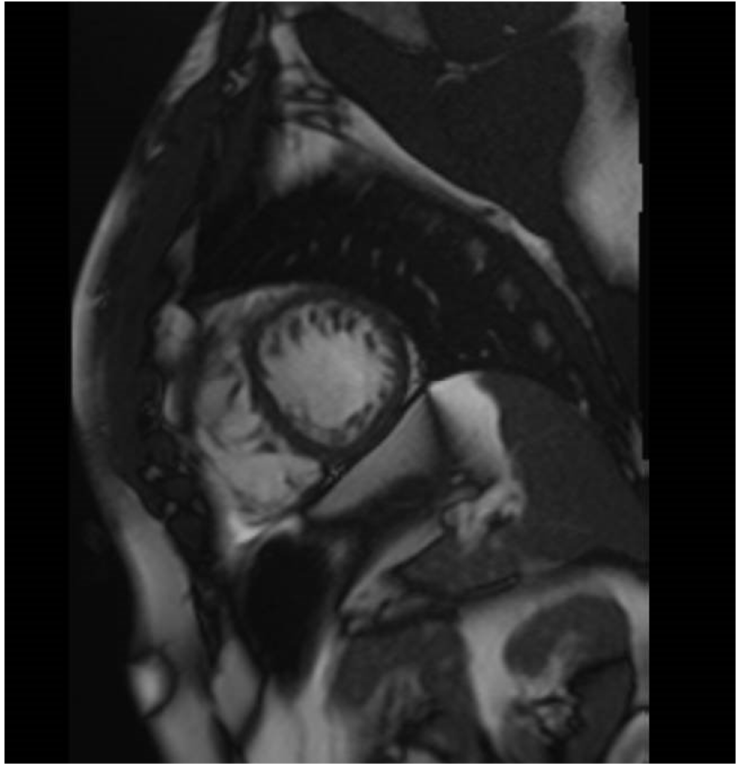
Figure 3. E.M. Cardiac MRI. SSFP cine sequence. Short-axis view, mid-segments. The image shows left ventricular non-compaction. MRI: magnetic resonance imaging. SSFP: steady-state free preces- sion.